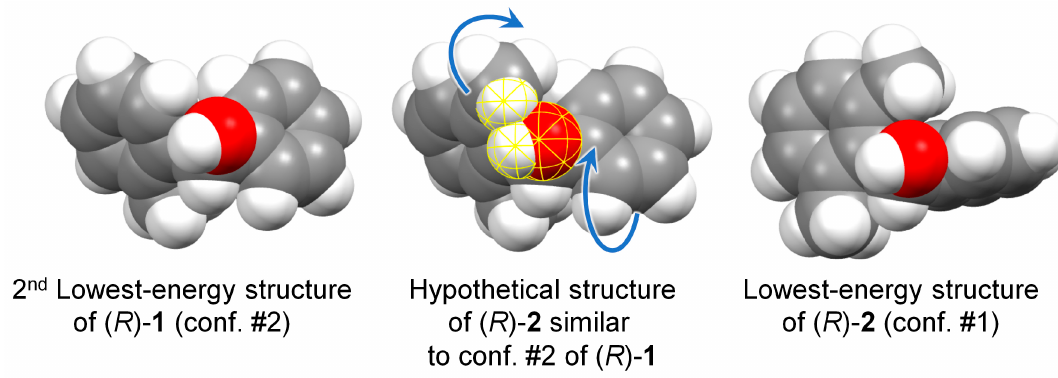
Figure 5. Space-filling models (90% Van der Waals radii) of the lowest-energy conformer of ( R )- 2 ( right ) and the second lowest-energy conformer of ( R )- 1 ( left ), and hypothetical structure of ( R )- 2 in the same conformation of ( R )- 1 ( middle ). In this latter, the atoms highlighted in yellow have short contacts (distance < sum of VdW radii), which are relieved by means of the rotations indicated by the blue arrows (leading to the lowest-energy structure on the right ).